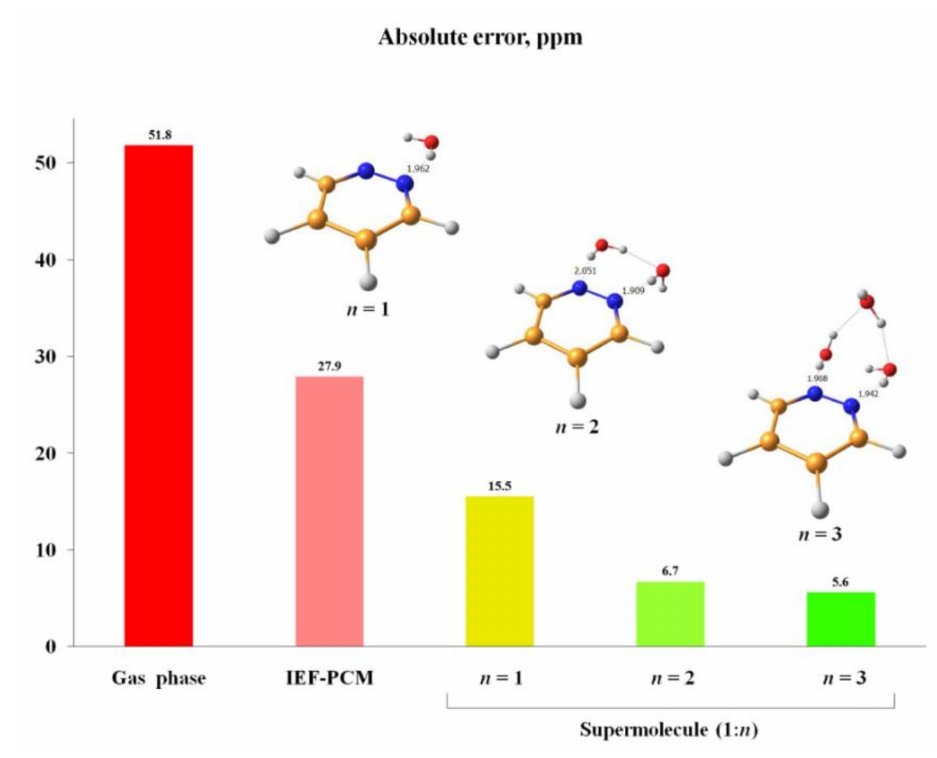
Figure 9. Absolute errors of the 15 N-NMR chemical shift of pyridazine in water calculated at the GIAO-DFT-KT3/pcS-3//pc-2 level with using different solvation models to account for solvent effect. The most characteristic interatomic distances in the solvate complexes 1:1 ( n = 1), 1:2 ( n = 2) and 1:3 ( n = 3) are given in Å. Reproduced from Semenov et al. [96] with the permission of John Wiley and